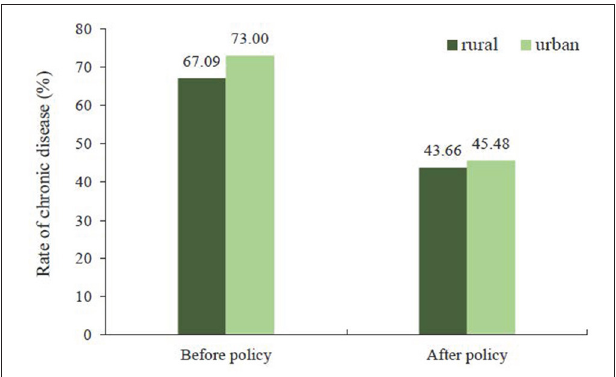
FIGURE 2 | Rate of chronic disease for urban residents and rural residents.